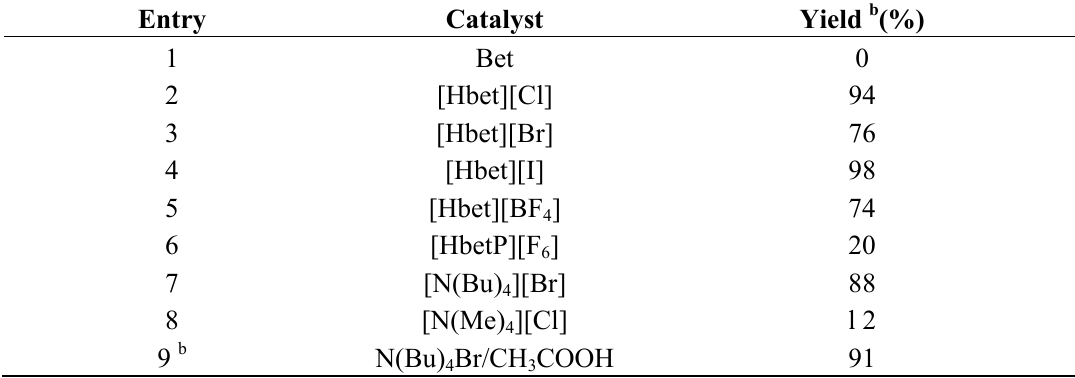
Table 4. Synthesis of propylene carbonate (PC) catalyzed by betaine(Bet)-based catalysts a